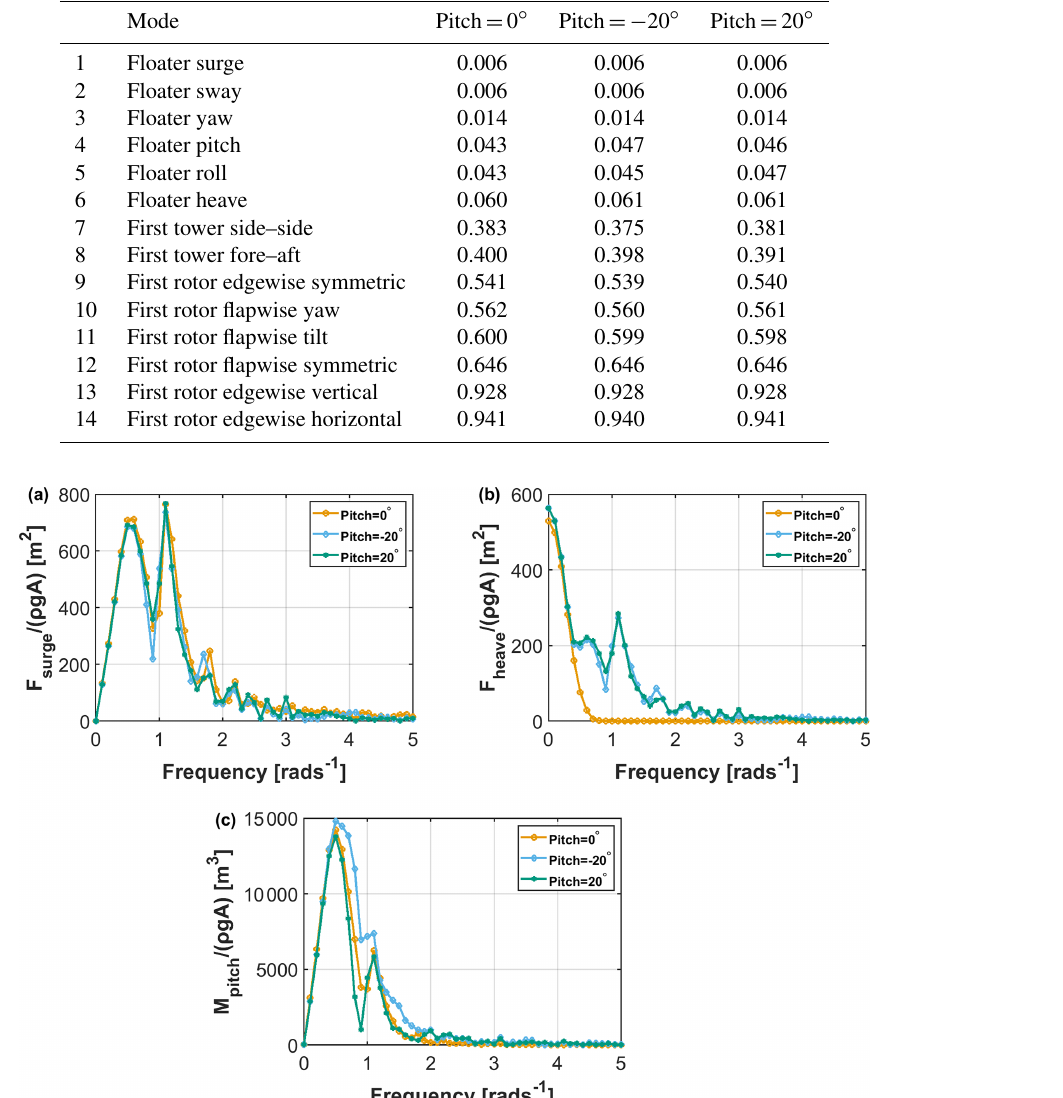
Figure 14. Comparison of the wave exciting loads for platform pitch angles 0 ◦ , 20 ◦ (wake-up), and − 20 ◦ (wake-down). Surge (a) ; heave (b) ; pitch (c)